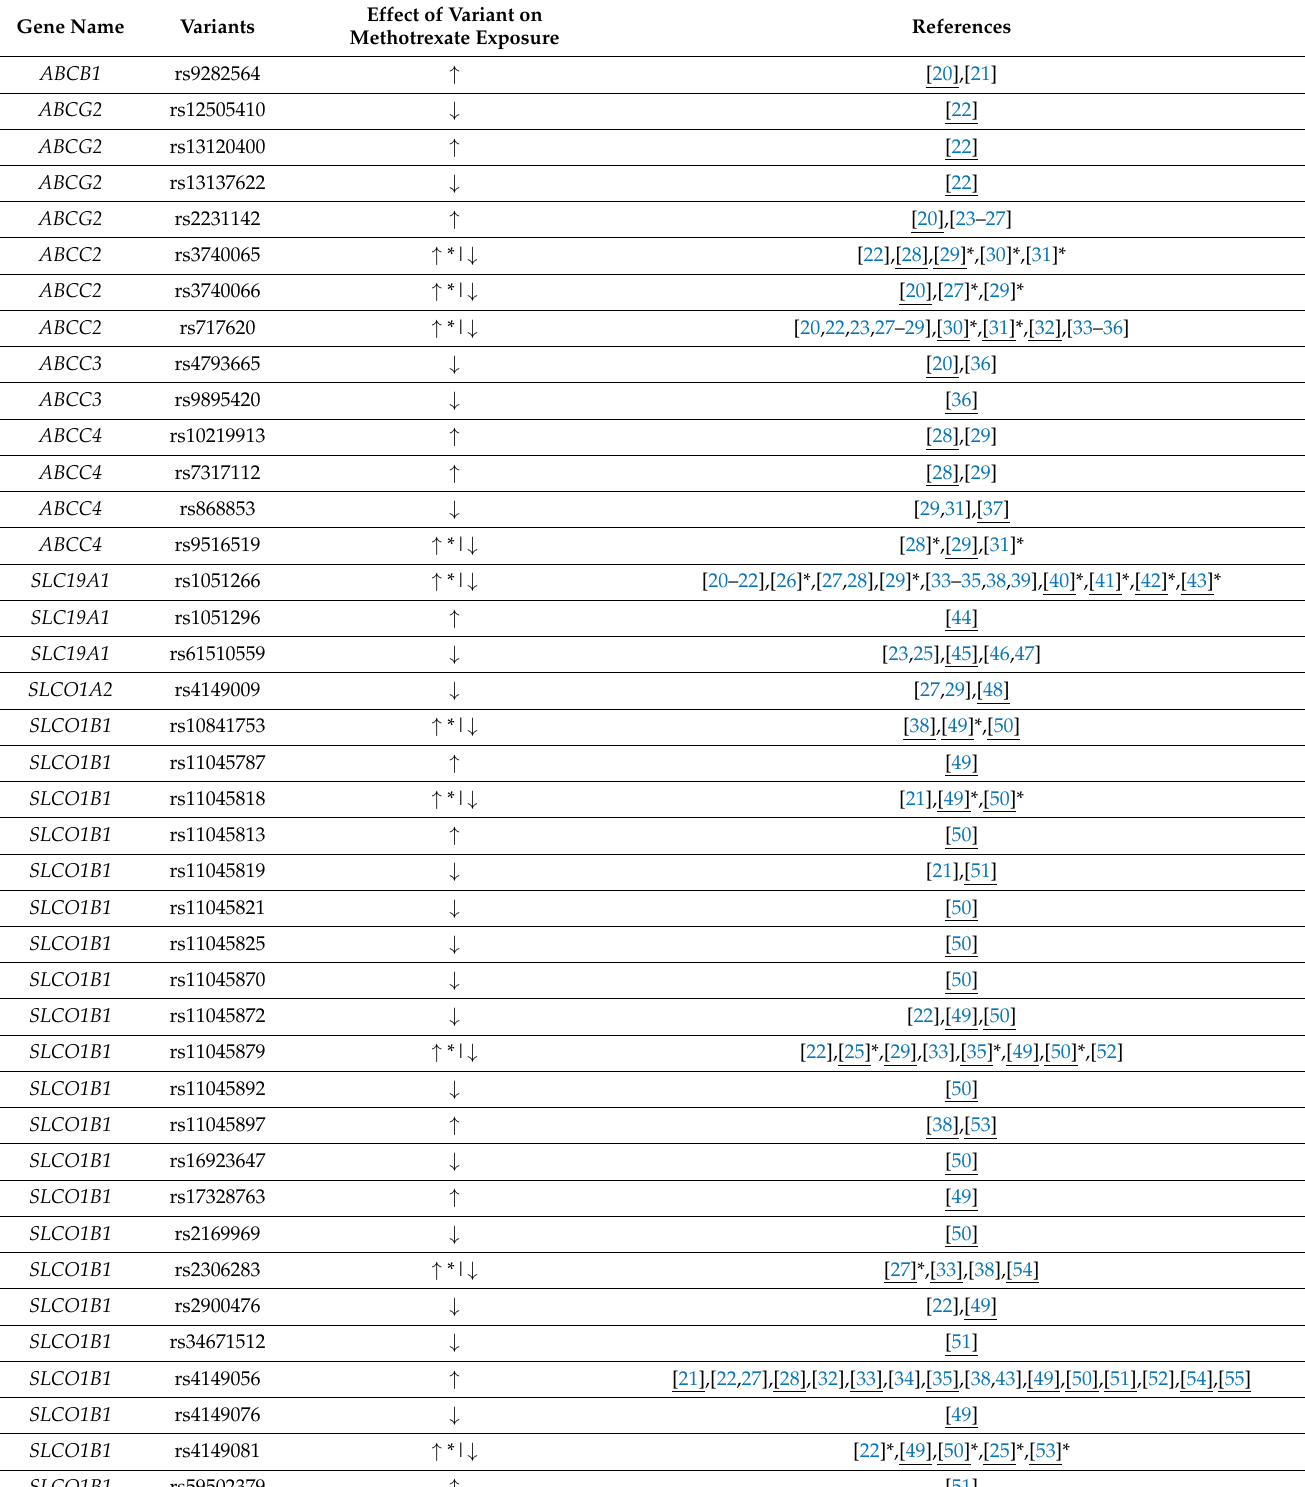
Table 1. Transporter Genes That Significantly Affect Methotrexate